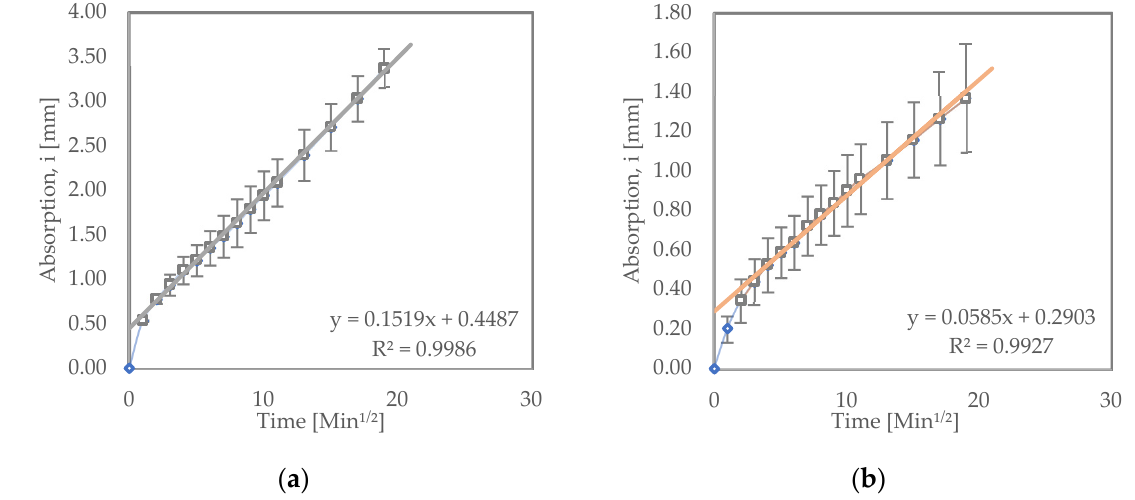
Figure 4. Sorptivity results for ( a ) OPC and ( b ) LC 3 samples subjected to wet–dry cycles. When compared to the LC 3 and OPC samples subjected to the wet–dry test, the LC 3